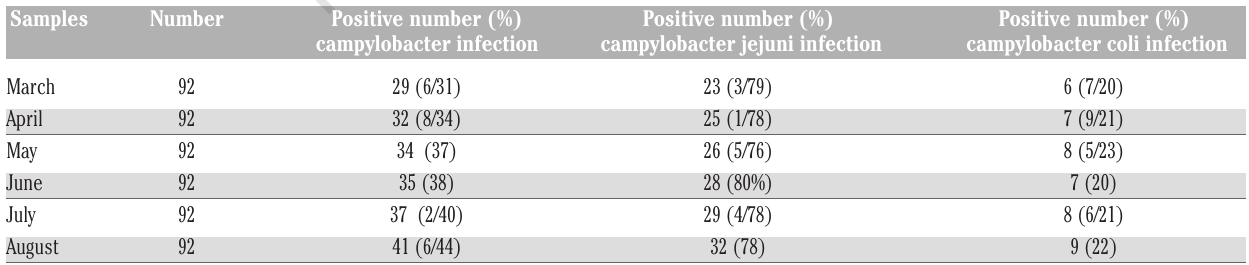
Table 3. Monthly contamination of chicken meat and its related edible offal to Campylobacter and its species. Samples